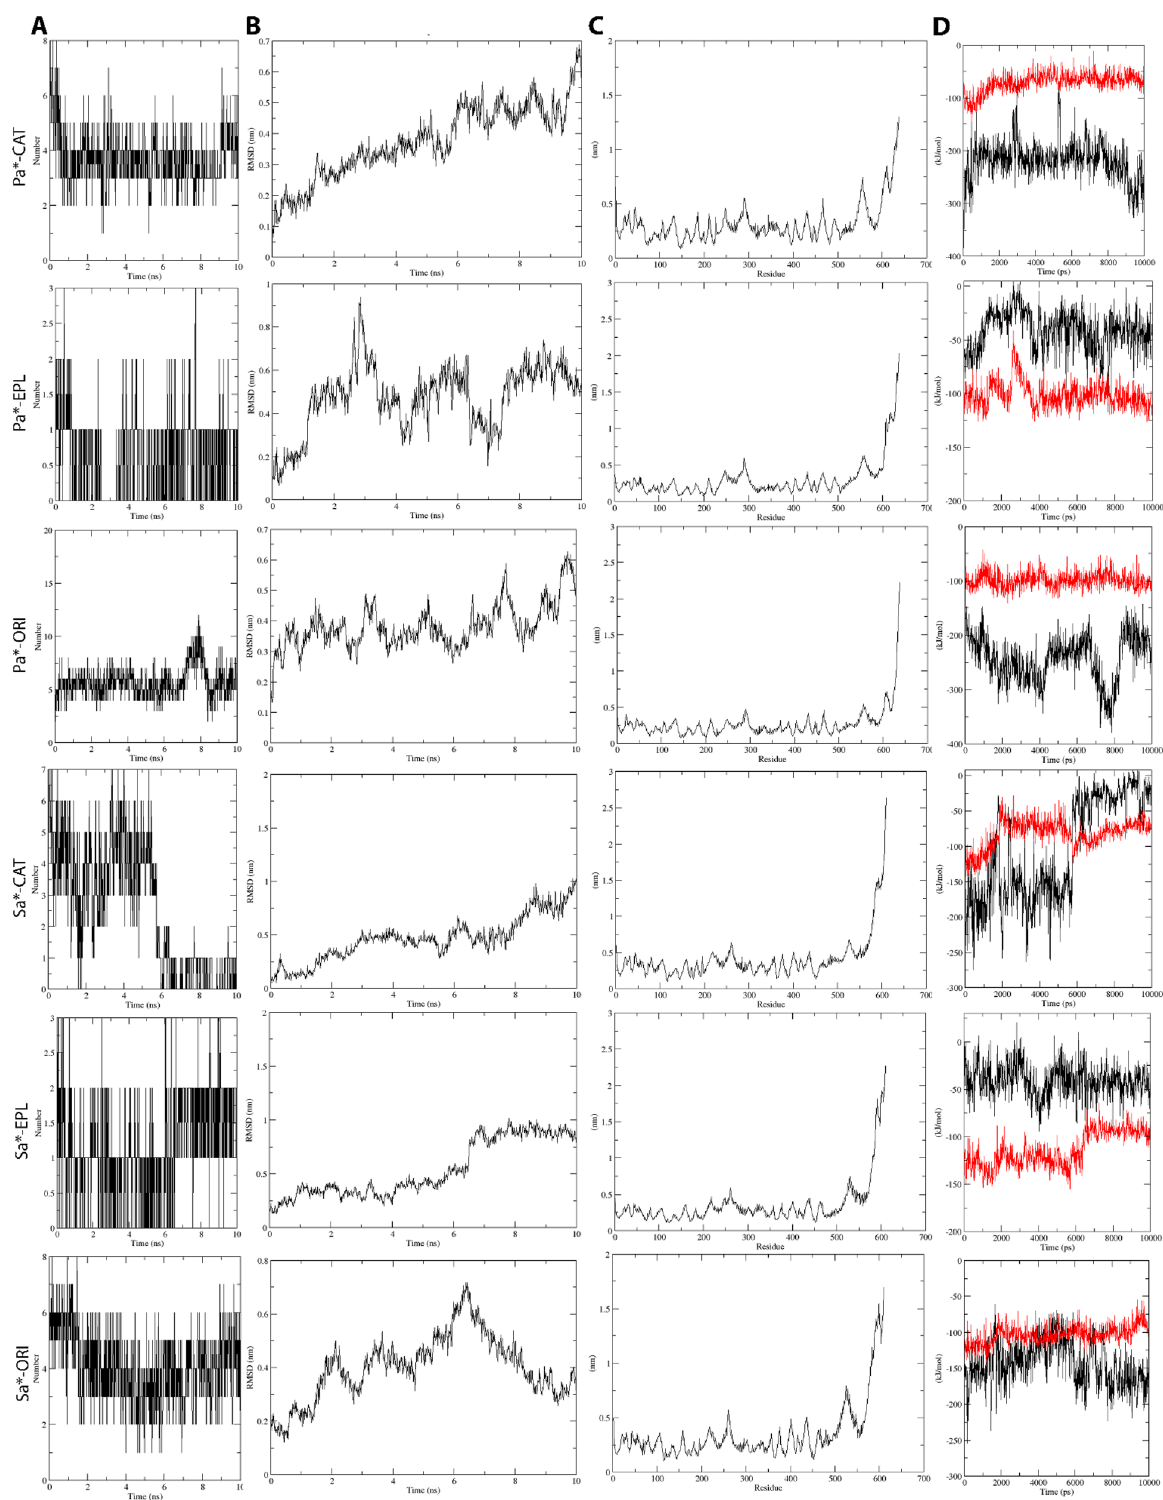
Figure 4. Receptor-ligand interactions over the course of MD simulation, of which ( A ) number of hydrogen bonds between receptor and ligand, ( B ) RMSD values of Catechin, ( C ) RMS fluctuation-per-residue of receptor macromolecule, and ( D ) receptor-ligand interaction energies (Black: Coulombic interaction energies, Red: Lennard–Jones energies) were computed over the course of MD. Note Pa*— P. aeruginosa , Sa*— S. aureus , CAT—Catechin, EPL—Eplerenone, ORI—Oritin-4-beta-ol. All data were generated using GROMACS 34 in-built